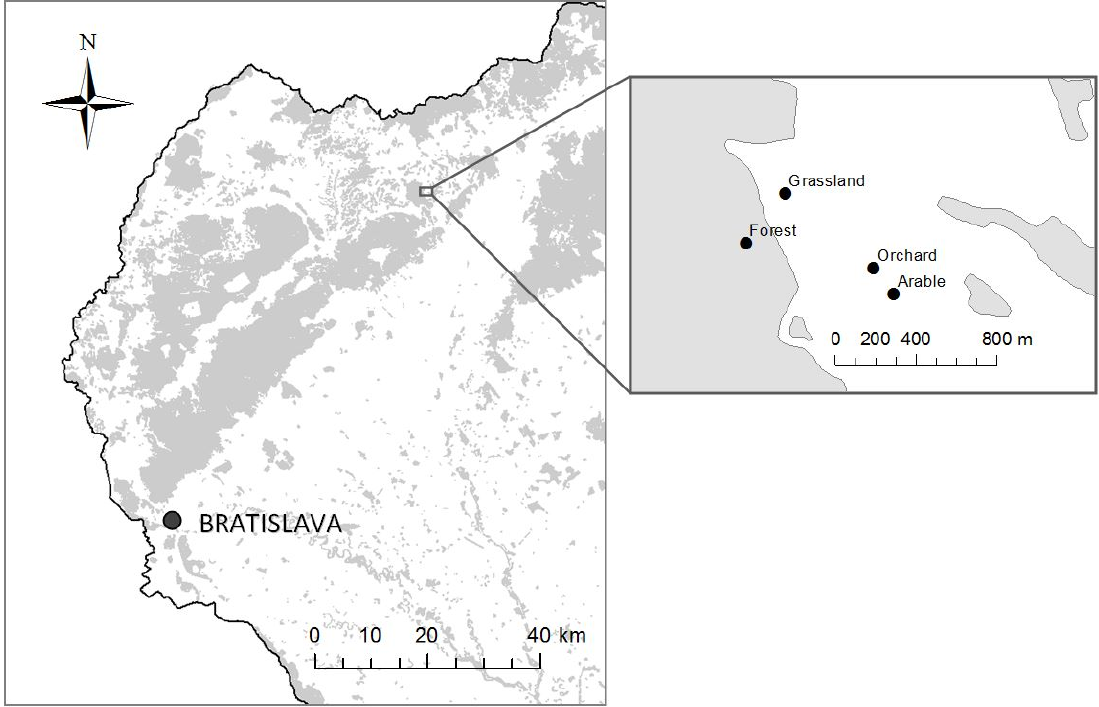
Figure 1. Location of the four research plots.